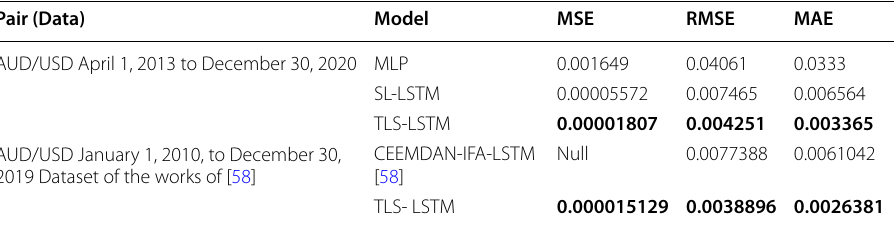
Table 1 Proposed model comparison with baseline models based on evaluation metrics Pair (Data) Model MSE RMSE MAE